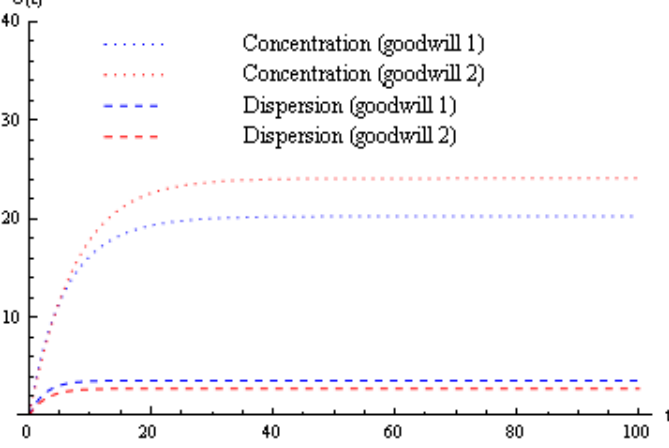
Figure 1. Product goodwill over time for different decision scenarios.